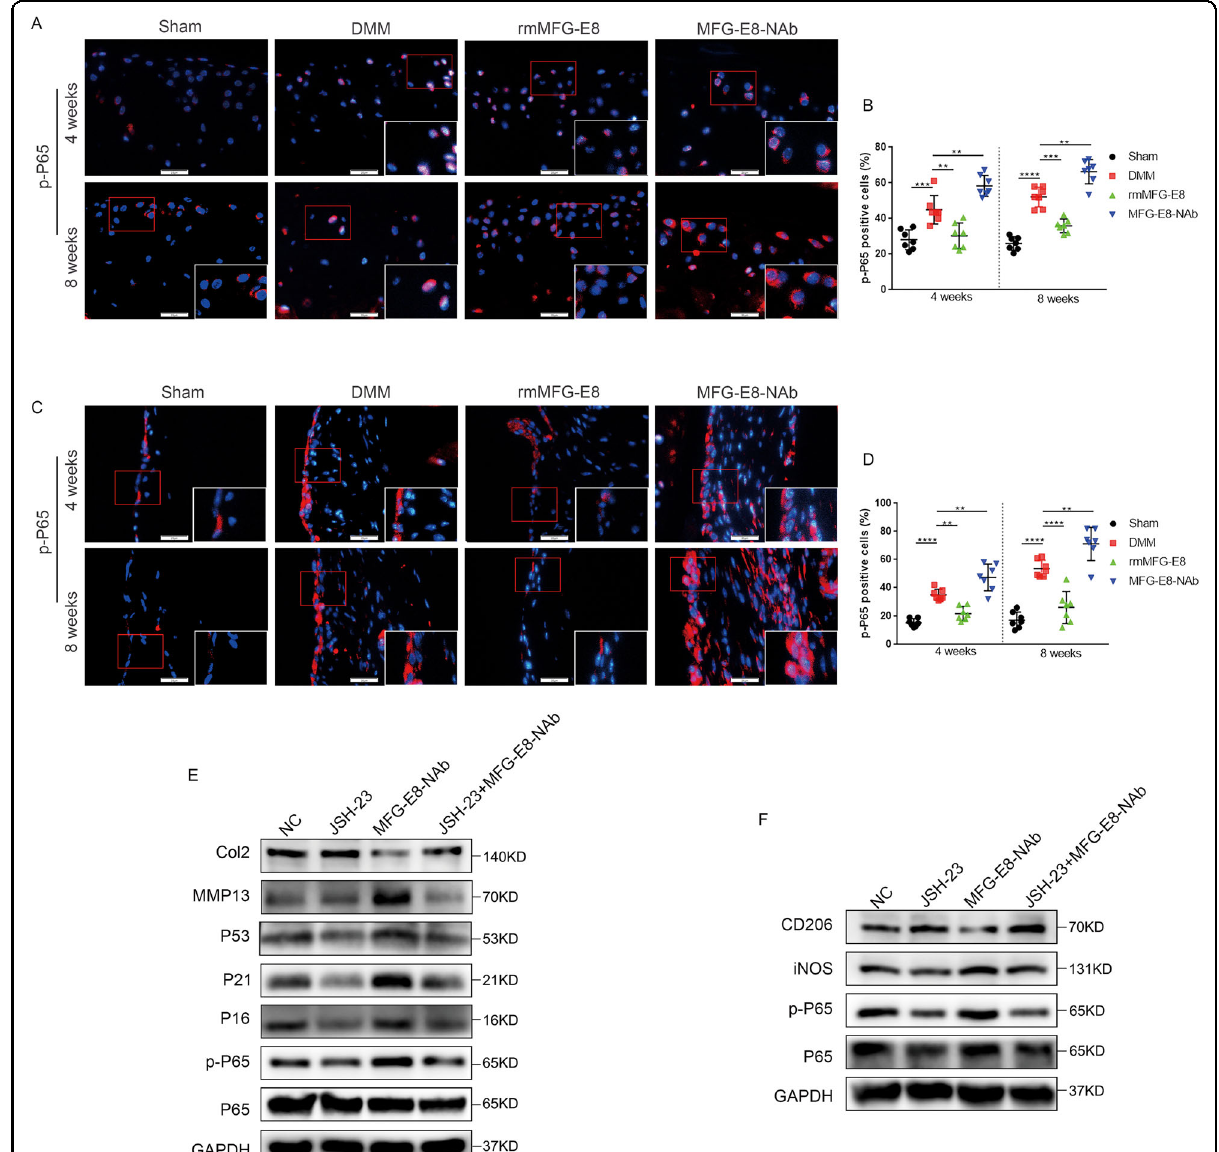
Fig. 5 MFG-E8 suppresses OA progression through inhibition of the NF- κ B pathway. Immuno fl uorescent staining and quanti fi cation of p-P65 in knee cartilage ( A , B ) and synovial tissue ( C , D ) of controls and mice administered vehicle, rmMFG-E8 or MFG-E8-NAb for 4 weeks or 8 weeks. n = 7 per group; Scale bar: 25 µm; E Immunoblotting of p-P65, P65, MMP13, Collagen II, and senescence markers (P16, P21, P53) of primary murine chondrocytes treated with JSH-23 or MFG-E8-NAb; F Immunoblotting of p-P65, P65, iNOS and CD206 of RAW264.7 cells treated with JSH-23 or MFG- E8-NAb. ** P < 0.01, *** P < 0.001 , **** P <